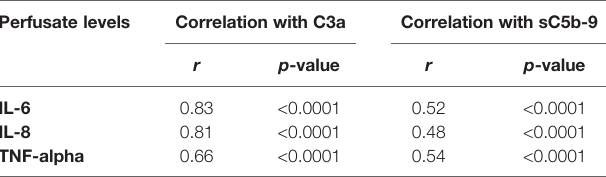
TABLE 2 | Correlation between complement perfusate levels and cytokine perfusate levels after 4 h of normothermic machine perfusion of porcine kidneys. Perfusate levels